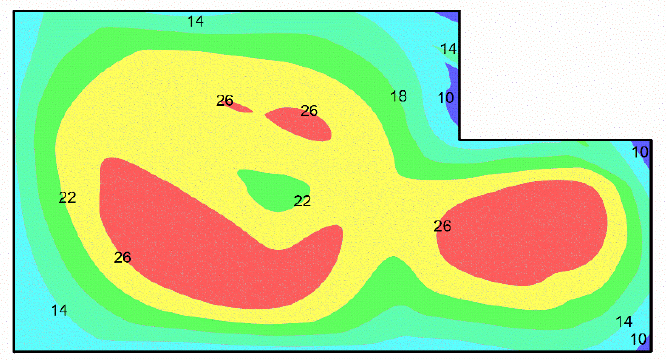
Figure 16. Contour maps of the vertical movements of the structures.